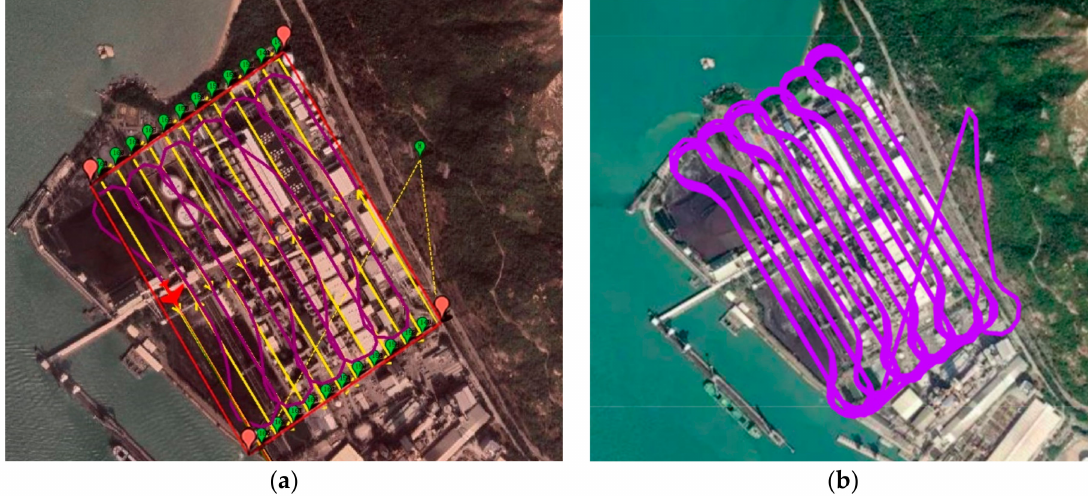
Figure 15. Bird’s eye view of the trajectory result of auto-grid paths in simulation platform 1 ( a ) and platform 2 ( b ).